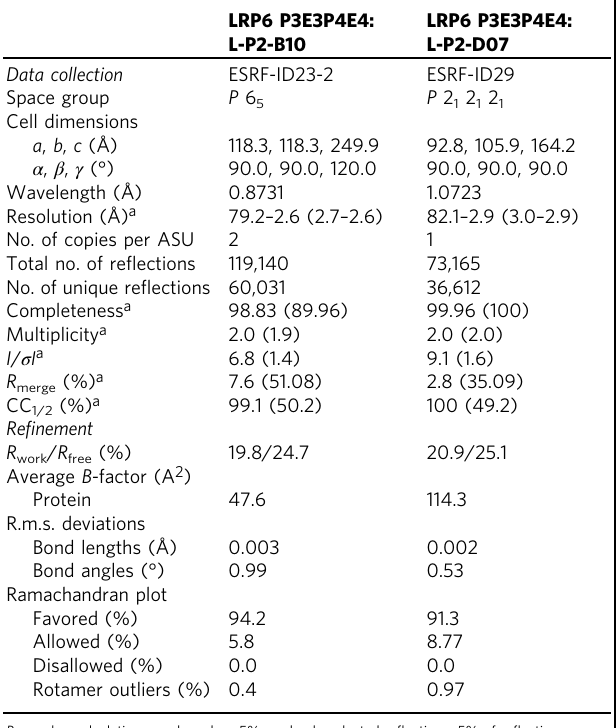
Table 1 Crystallographic and structure re fi nement statistics